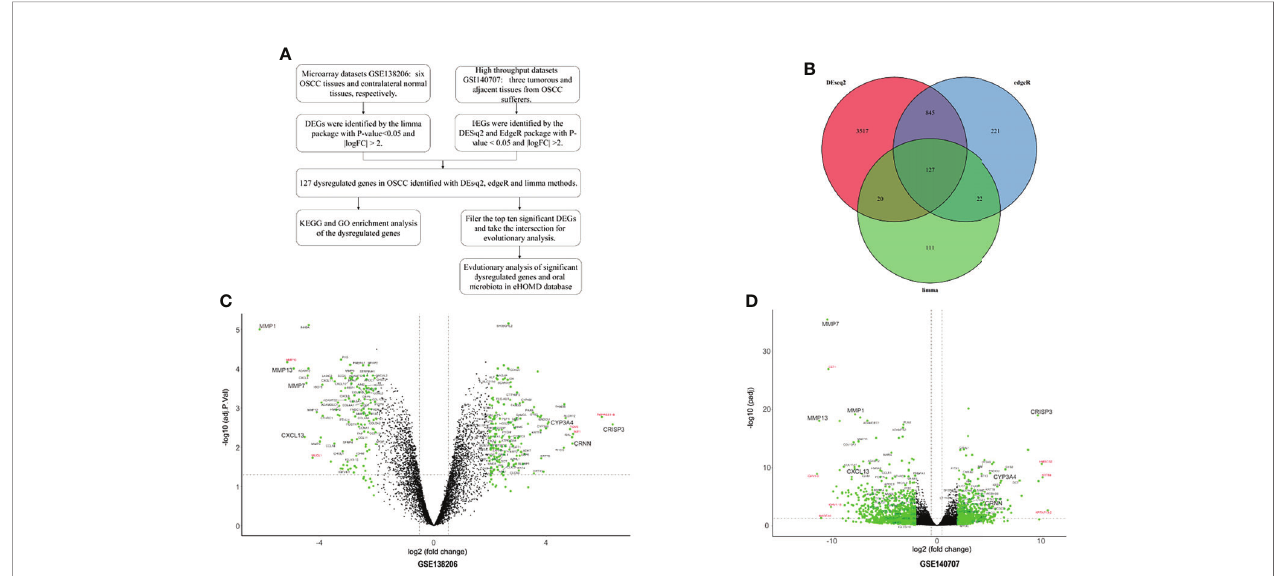
FIGURE 1 | The identi fi ed of DEGs. (A) The fl owchart of research design. (B) The two datasets showed an overlap of 127 differentially expressed genes (DEGs) which were identi fi ed by three different methods. (C) The volcano map of microarray dataset GSE138206. (D) The volcano map of high-throughput sequencing dataset GSE140707. The DEGs are marked in light blue; the 127 common DEGs are labeled with black, and red labels are DEGs in each